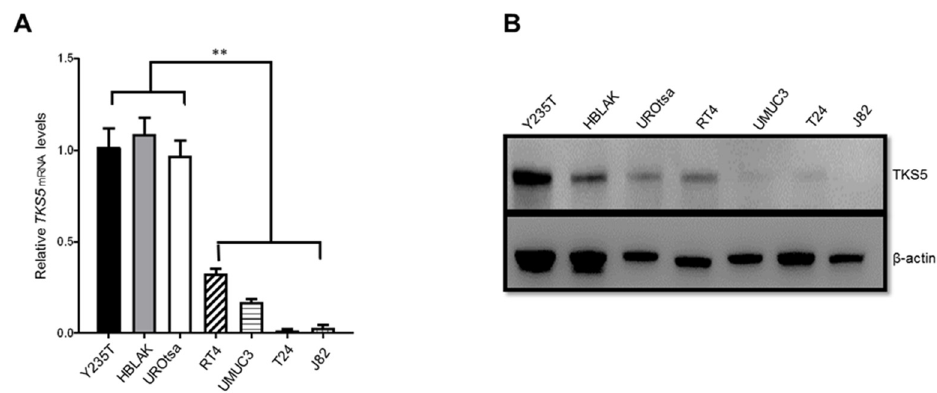
Figure 2. TKS5 mRNA and protein levels in immortal urothelial cell and bladder cancer cell lines. ( A ) Relative TKS5 mRNA levels, and ( B ) TKS5 protein levels in immortalised urothelial cell lines Y235T, HBLAK, UROtsa and bladder cancer cell lines RT4, UMUC3, T24 and J82. The expected size of the TKS5 protein is around 130–150 kDa. We used β -actin (42 kDa) for loading and quality control. ( A ) Results of three technical repeats of RT-qPCR experiments. ( B ) Western blot results, depicting representative results of at least three independent experiments. We used analysis of variance (ANOVA) to analyse the statistical significance. Error bars represent mean +/ − SD (** p < 0.01).